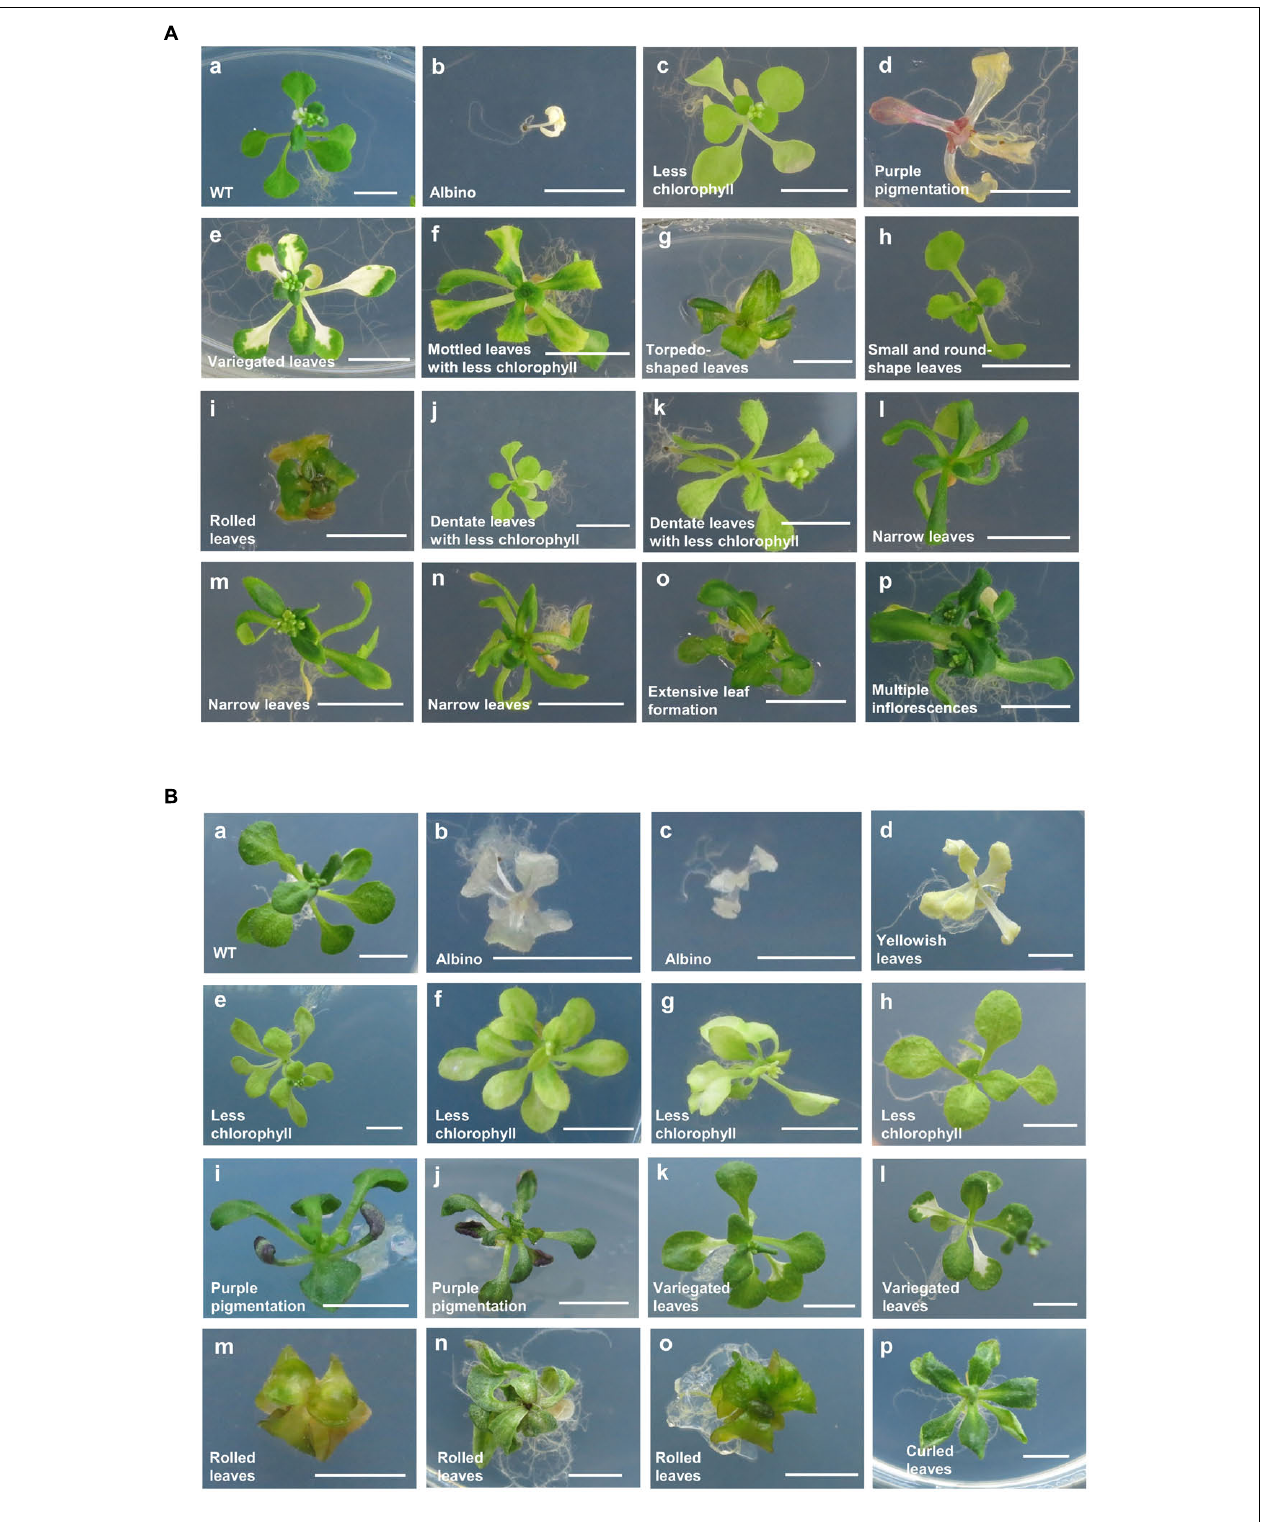
FIGURE 2 | Representative mutant phenotypes detected in M 2 populations. Mutant phenotypes were classified in M 2 populations derived from proton beam (A) and gamma-ray (B) irradiation. Images were taken on plates 22 days after sowing. Scale bars, 0.5 cm.